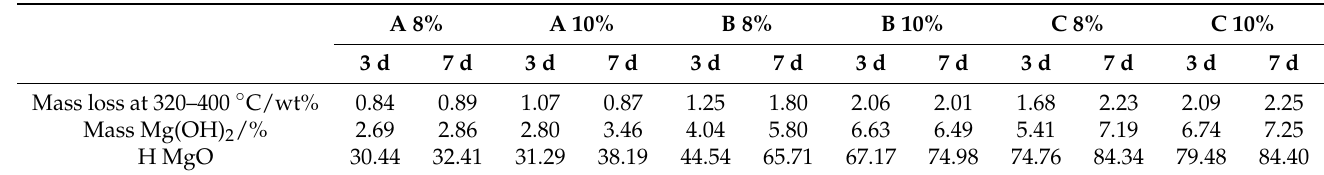
Table 4. Estimated quantity of Mg(OH) 2 and hydration degree of MgO in cement pastes contain- ing MEA.